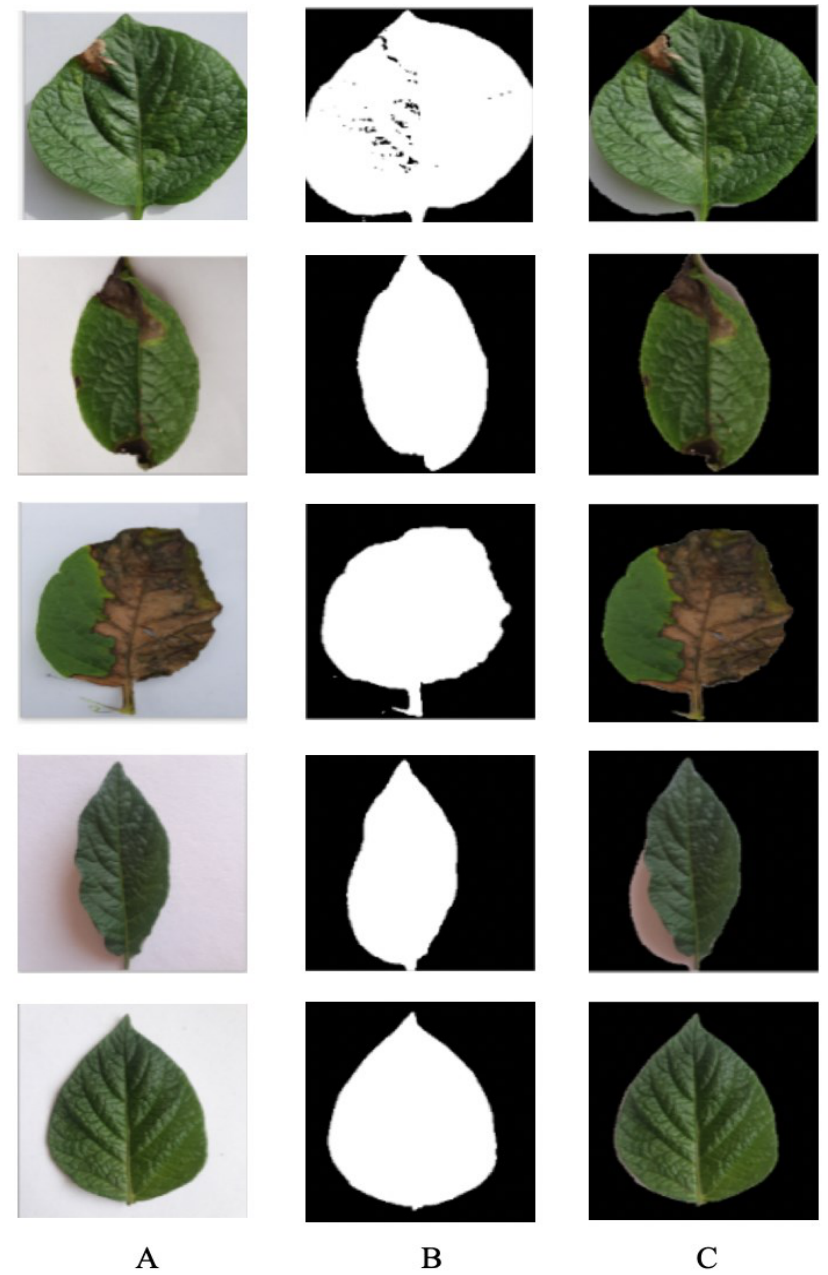
Figure 6. Result obtained from the application of segmentation algorithm.